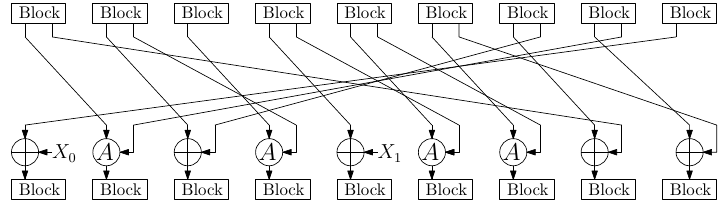
Figure 7: The round function whose # of blocks is 9.